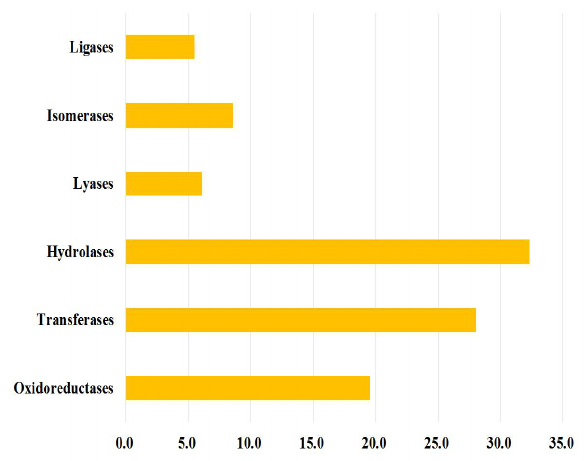
Figure 7. Distribution of Enzymes in the SSR-containing unigenes.